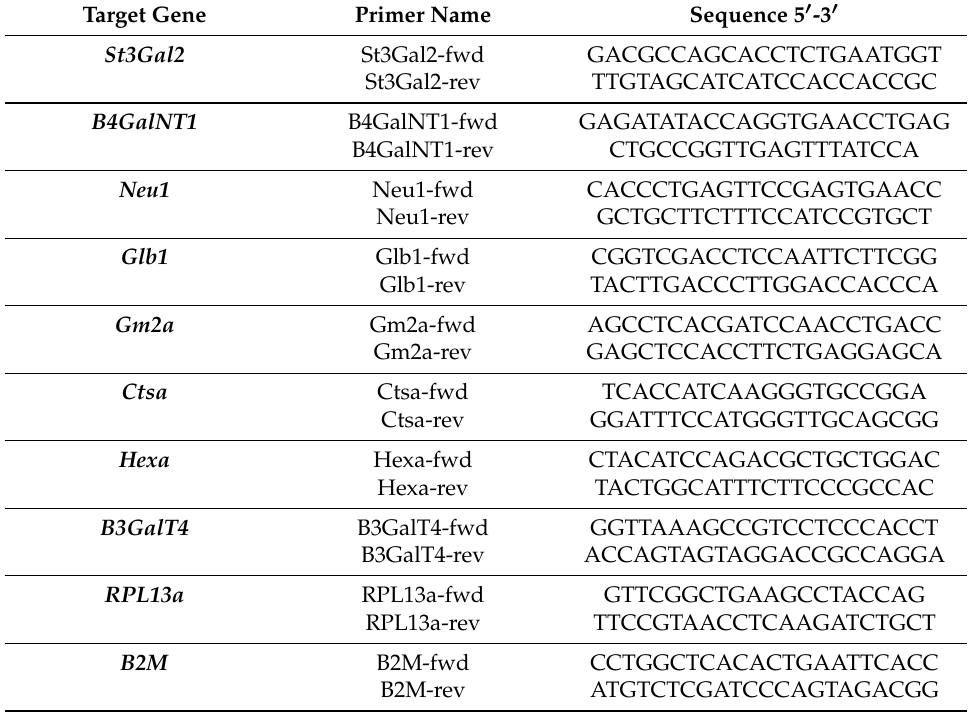
Table 3. Oligonucleotides used for quantitative real-time PCR analysis. Target